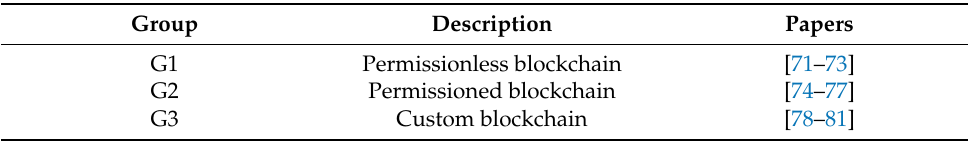
Table 3. Thematic categories in identified